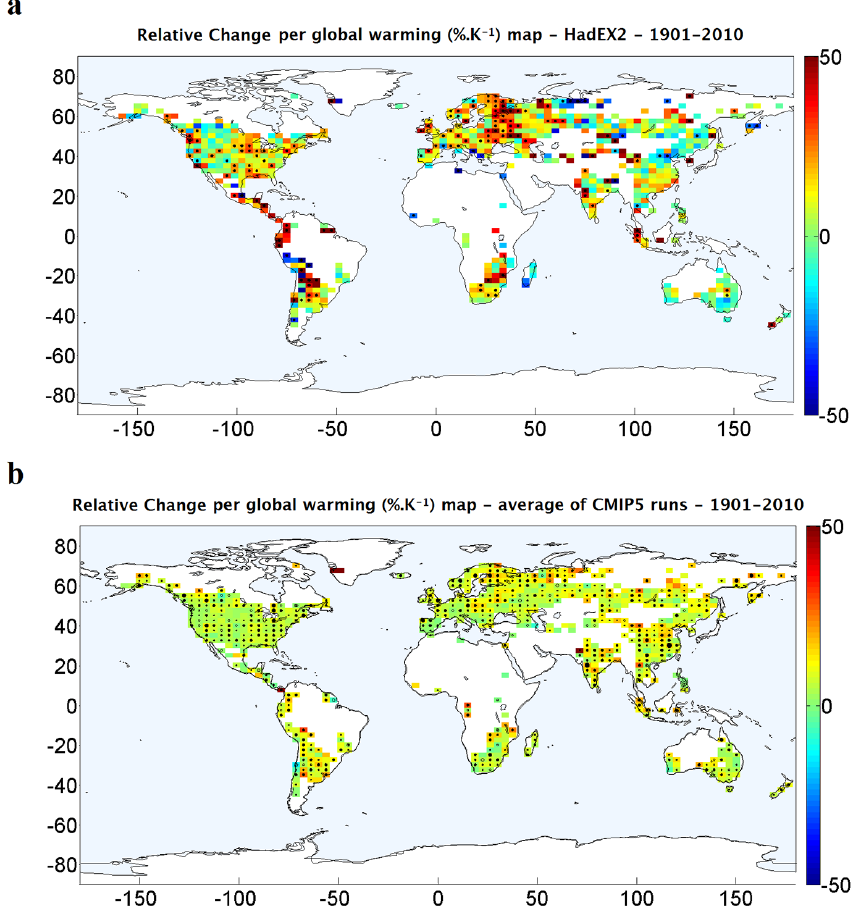
Figure 7. Relative change in extreme precipitation per K of global warming (%K − 1 ) maps for 1901–2010 for (a) HadEX2 observations and (b) the average of CMIP5 model